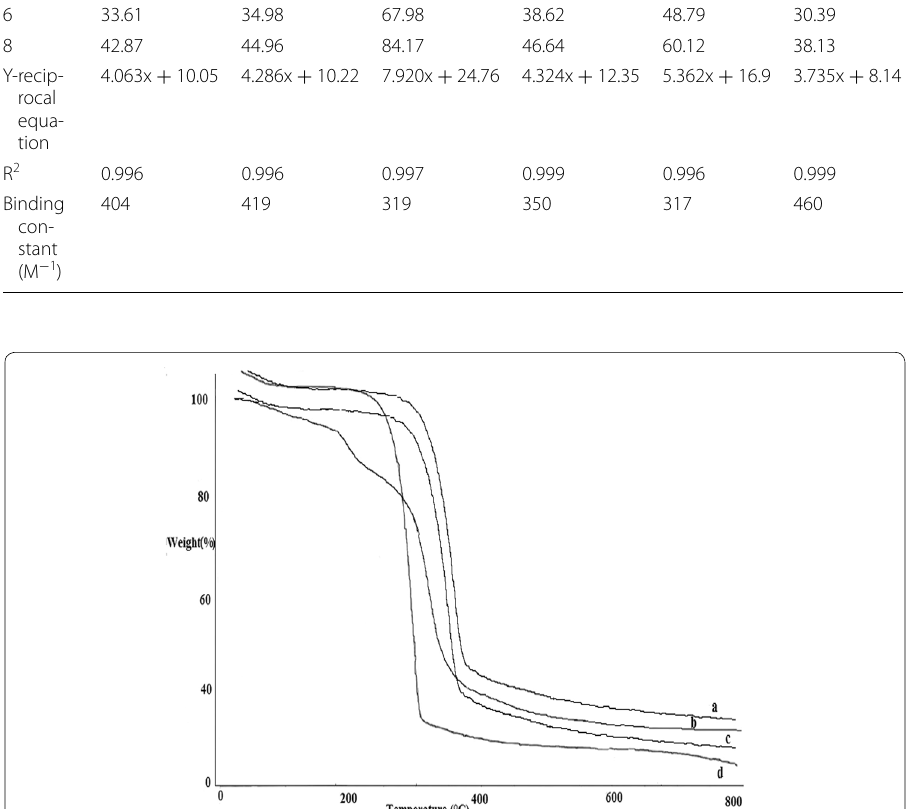
Fig. 9 TGA (a) Cotton treated with IC of β-CD CA (70 gpl): Oil (10%) (b) β-CD CA (70 gpl) (c) β-CD CA treated cotton (d)